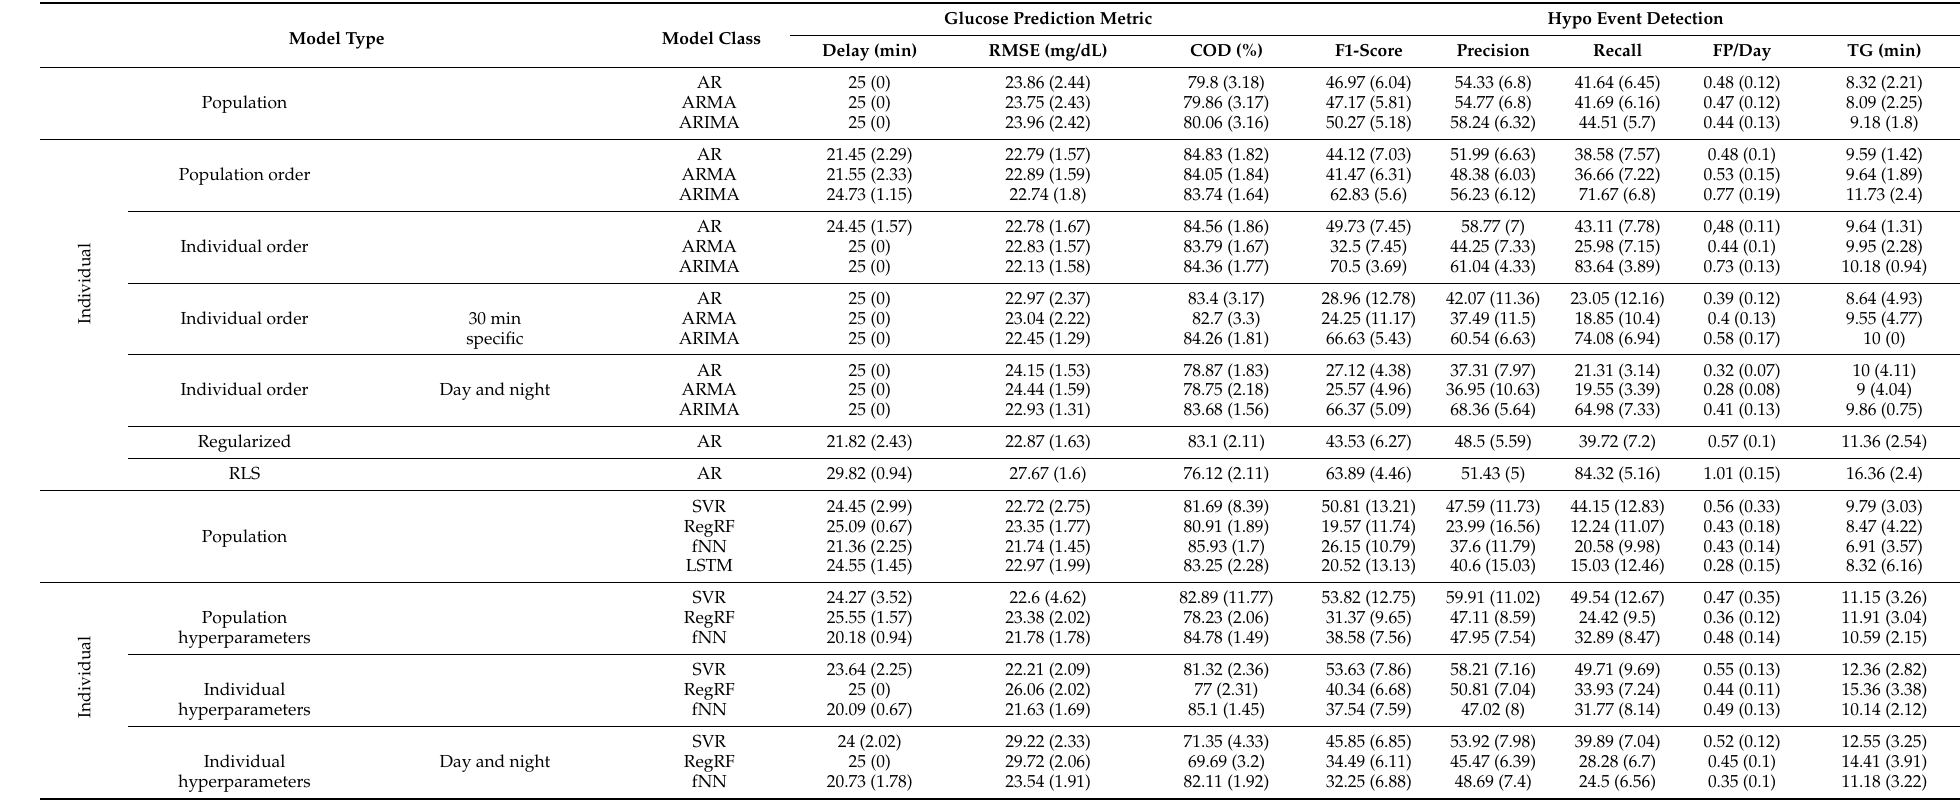
Table 4. Performance of nonlinear algorithms with a representative dataset partitioning (30-min